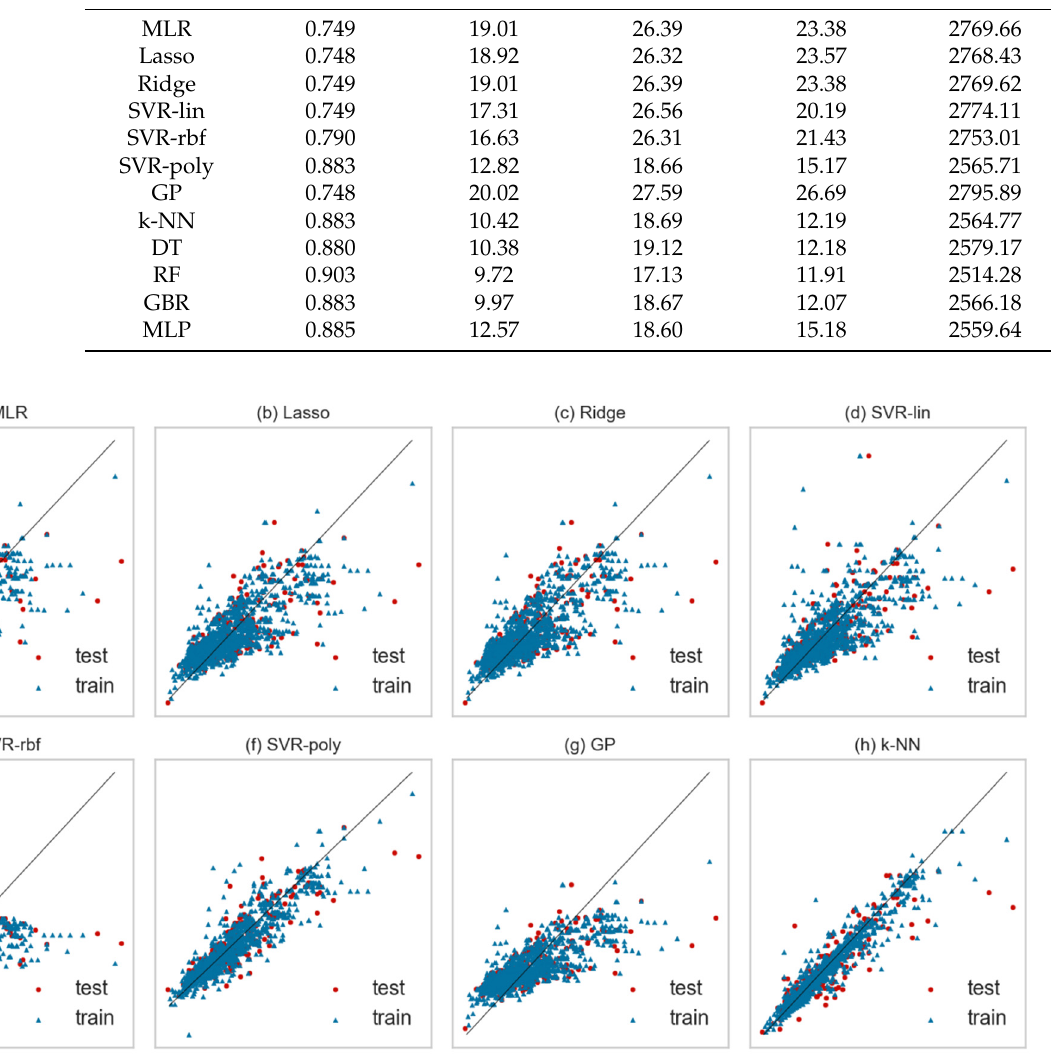
Table 8. Measures of accuracy comparison. Values for each measure correspond to the percentage of loss when the all-input case is substituted by the six PCA inputs case. R 2